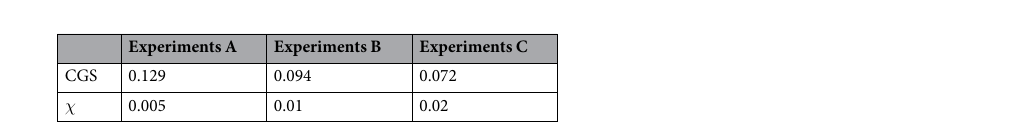
Table 3. The critical gas saturation (CGS) and χ obtained in experiments A, B, and